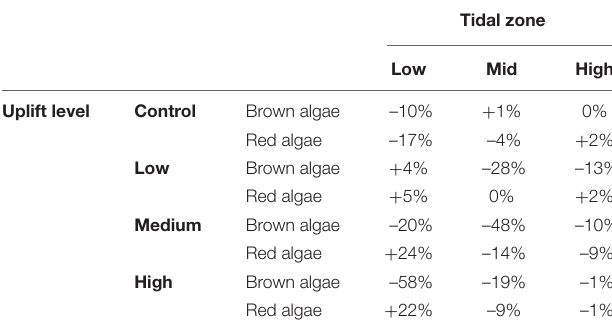
Data are compiled across all sites within each uplift